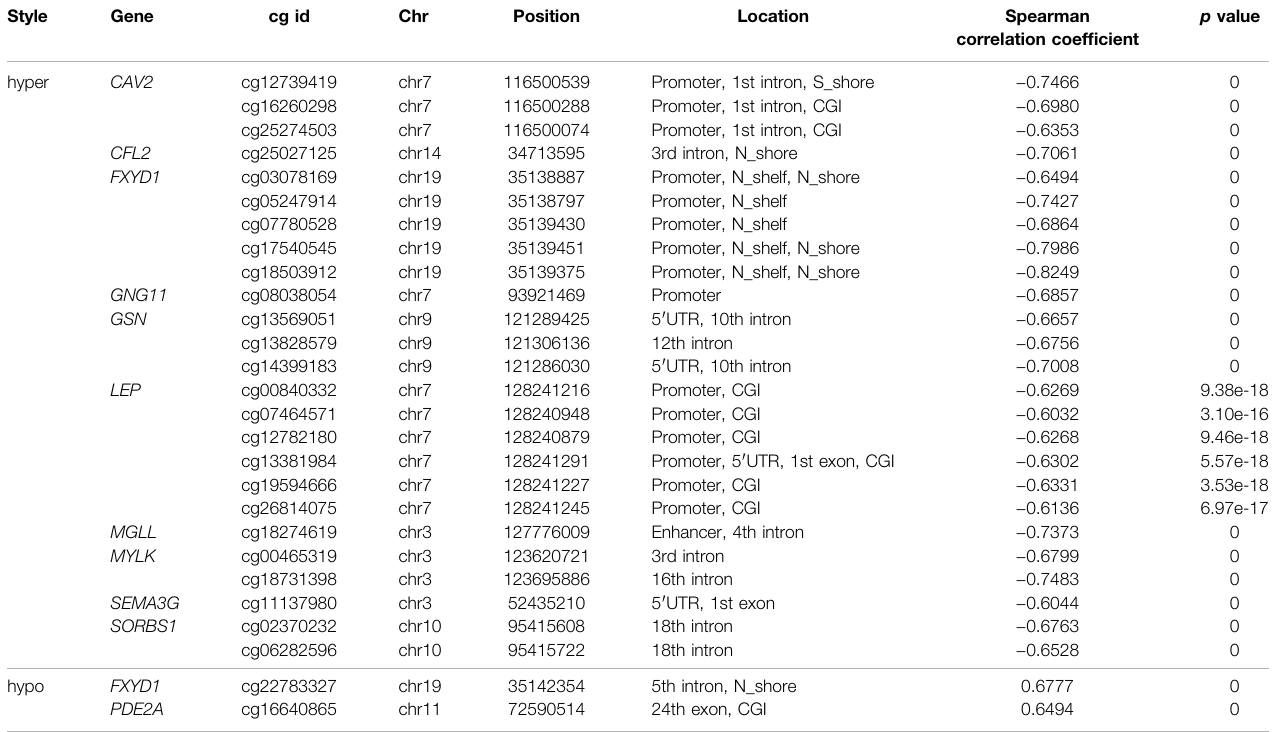
TABLE 1 | Table of ADMPs signi fi cantly correlated with gene